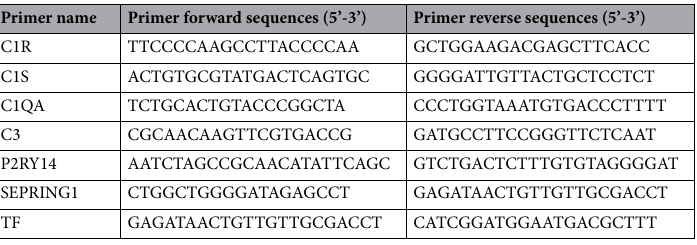
Table 1. Detail information of